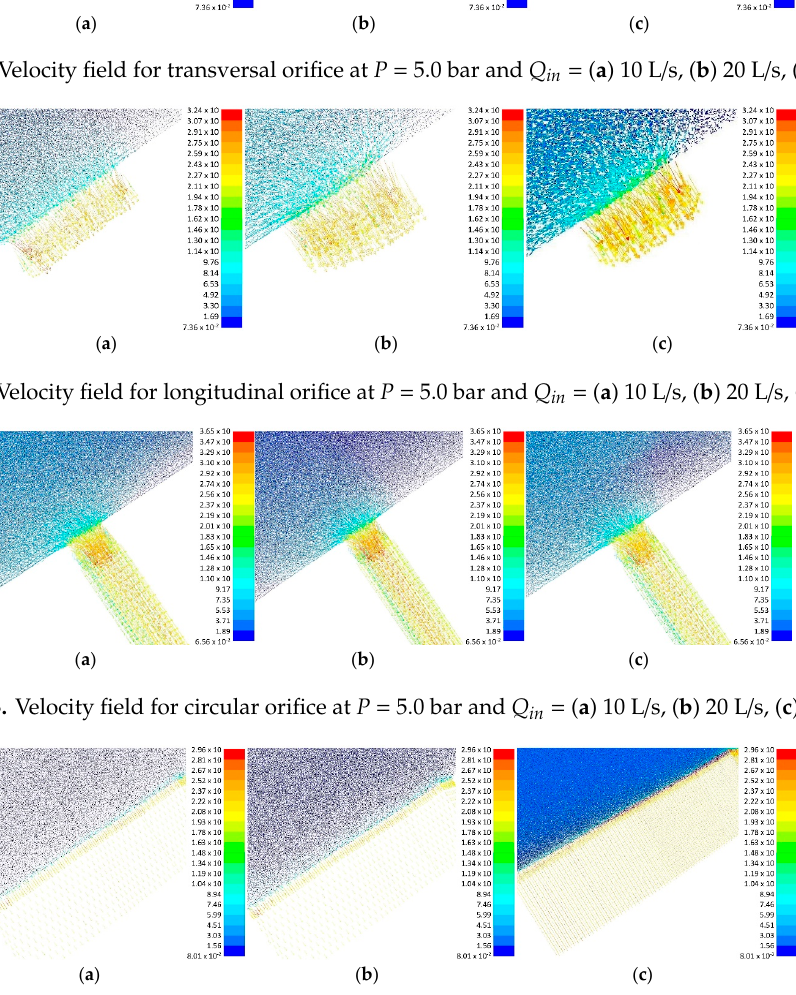
= ( a ) 10 L / s, ( b ) 20 L / s, ( c ) 30 L / in